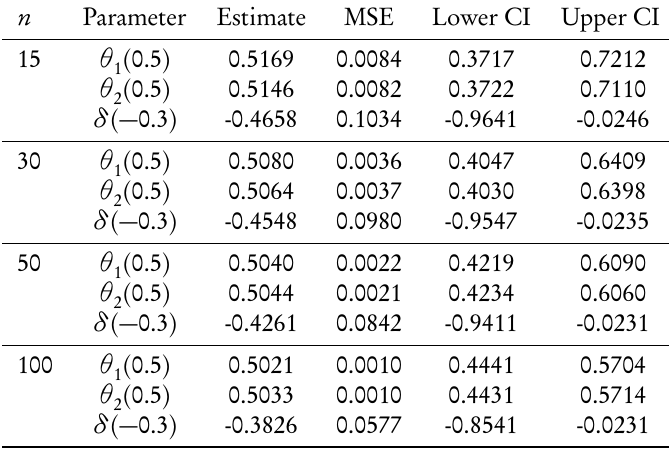
Simulation study of the parameters of BXG distribution (Case 1 -